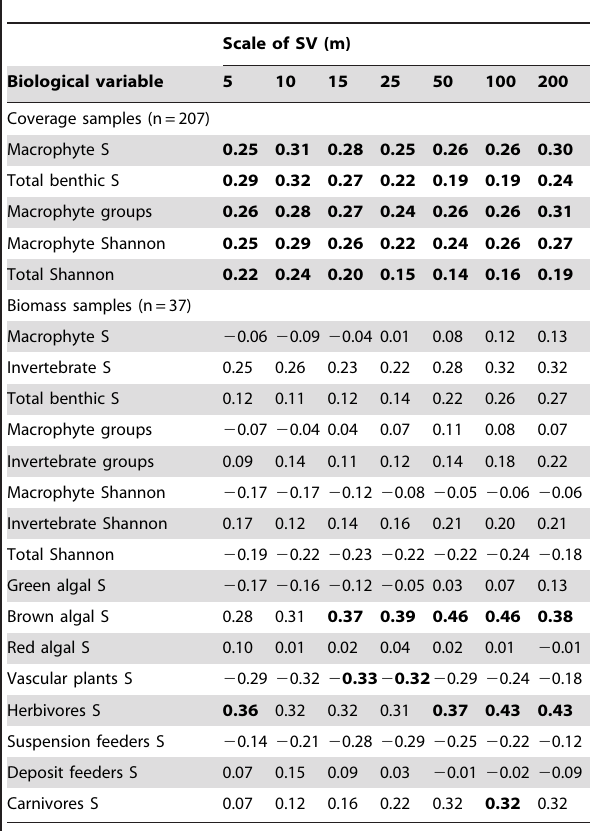
Table 6. Pearson correlation coefficients between SV and biological variables at different spatial scales